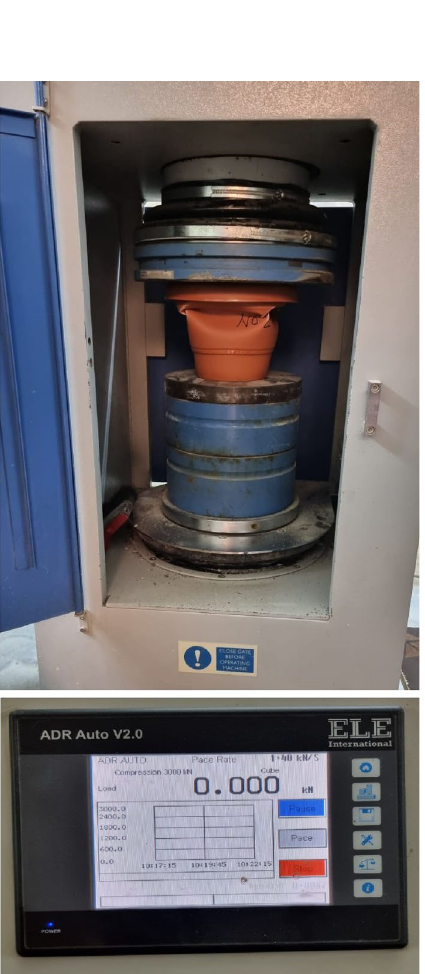
(b) Final product without surface polishing.